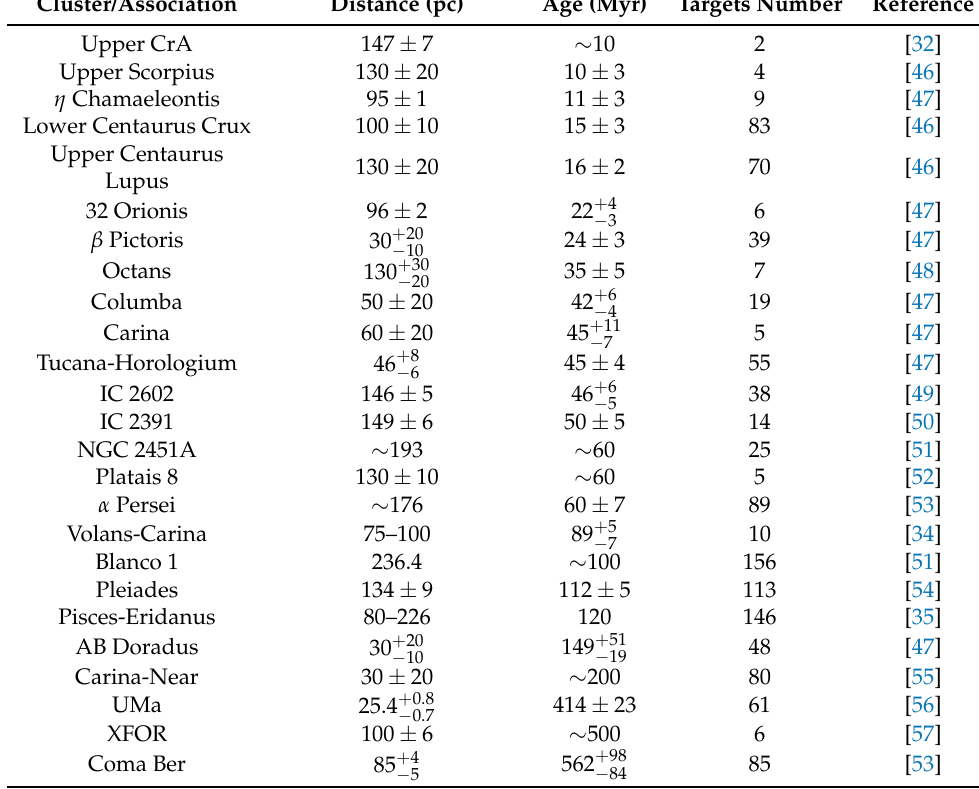
Table 1. Number of targets analyzed in this work. We show the number of targets analyzed using TESS 2-min cadence data from young clusters and associations in this work. We list the young clusters and associations by the order of their ages, which are adopted from literature works shown in the reference